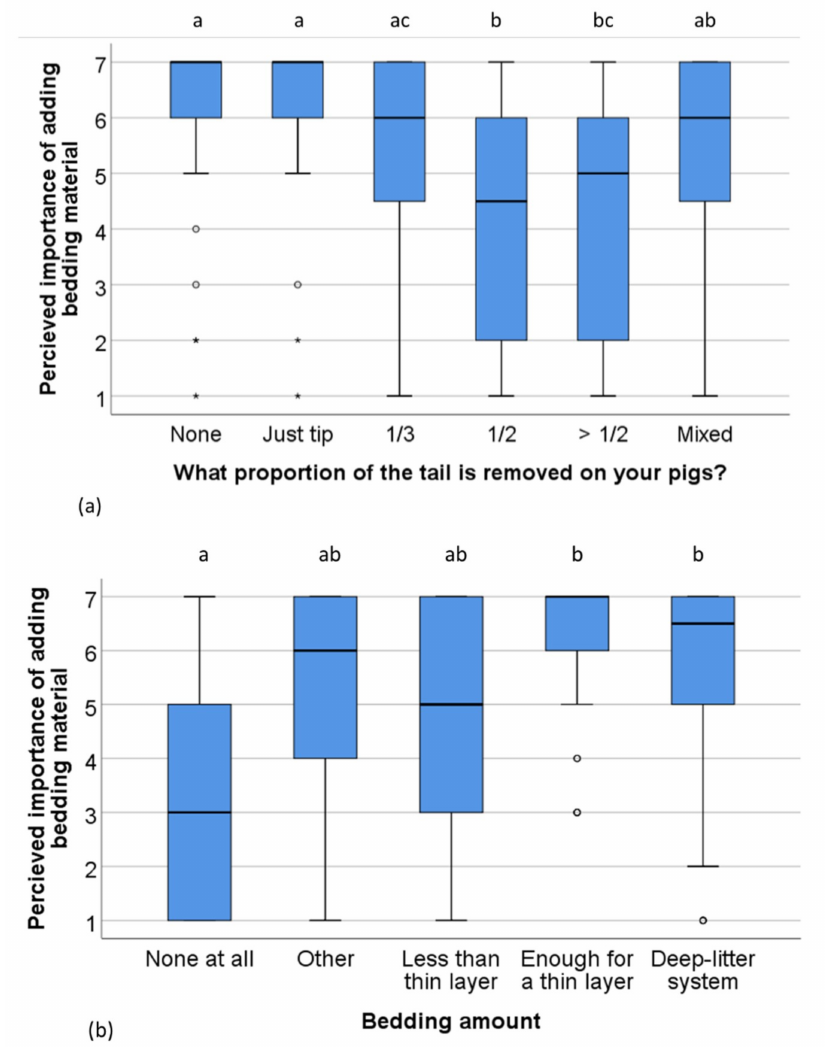
Figure 2. Scoring of the importance of Adding bedding material as an intervention measure when tail biting occurs in a pen on ( a ) farms which rear pigs with di ff erent proportions of the tails removed ( n = 176) and ( b ) using di ff erent bedding amounts ( n = 180). Scale: 1 (not important) to 7 (extremely important). The boxplot indicates medians and quartiles (25 and 50%) as well as outliers. Boxes lacking common letters di ff er ( p <